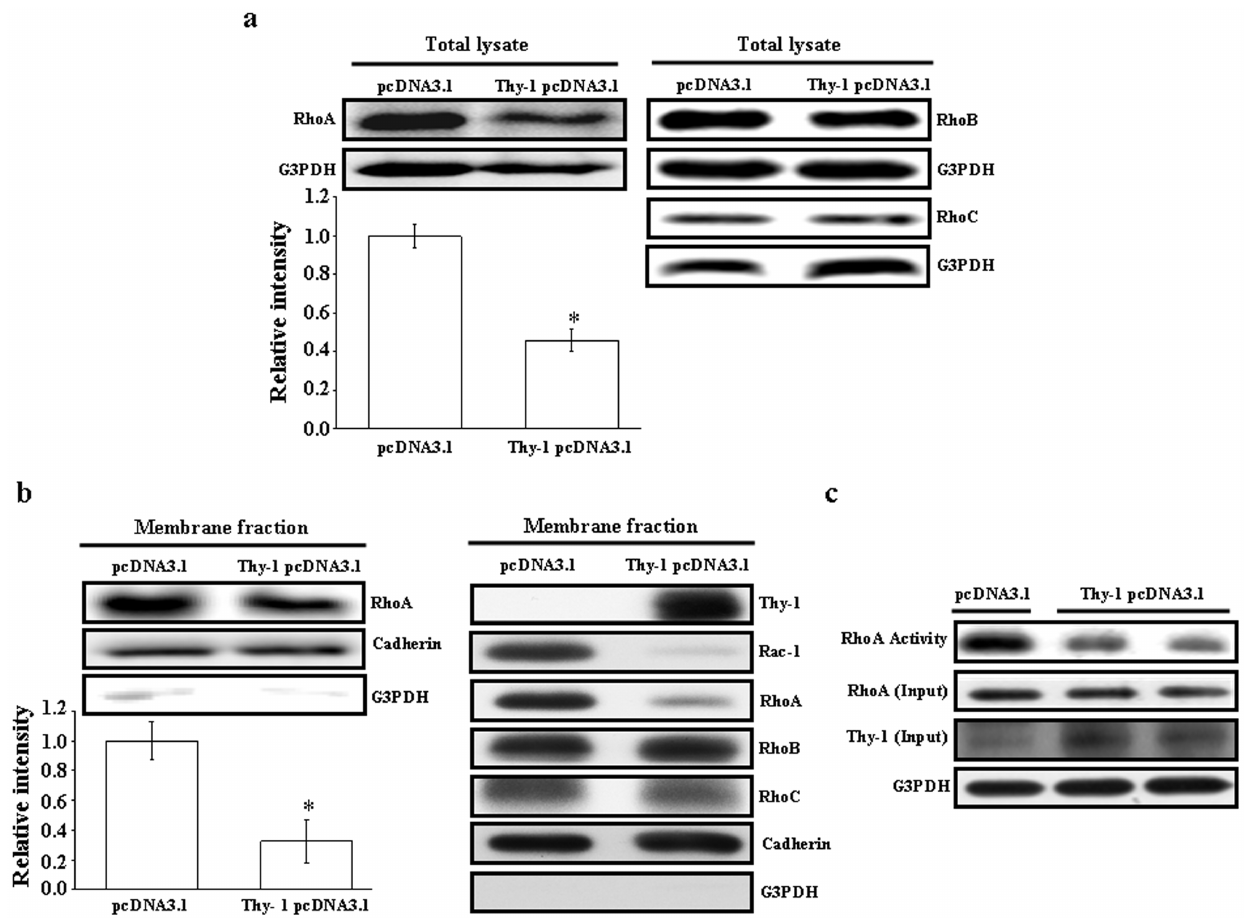
Figure 4. Effects of Thy-1 on expression and activity of RhoA in HUVEC. HUVEC were transfected with Thy-1 pcDNA3.1 or pcDNA3.1 (control). (a) Over-expression of Thy-1 inhibited the total protein levels of RhoA. The bottom panel shows the quantified results after adjusted with their own total protein levels and expressed by fold of control (left panel). Values represent the means 6 s.e.mean. (n=3). * p , 0.05. In contrast, the total protein levels of RhoB and RhoC were not significantly affected by over-expression of Thy-1 (right panel). (b) Over-expression of Thy-1 suppressed membrane-bound RhoA. Proteins were detected for RhoA, cadherin and G3PDH by Western blot analysis. Cadherin was used as a cell membrane protein marker to confirm the purities of isolation. The bottom panel shows the quantified results after adjusted with their own total protein levels and expressed by fold of control (left panel). Values represent the means 6 s.e.mean. (n=3). * p , 0.05. The protein levels of membrane- bound Rac-1, but not RhoB and RhoC, were also decreased by over-expression of Thy-1 (right panel). (c) A reduced RhoA activity was observed in the HUVEC transfected with Thy-1 pcDNA3.1 as compared with transfected with pcDNA3.1 (control vector).